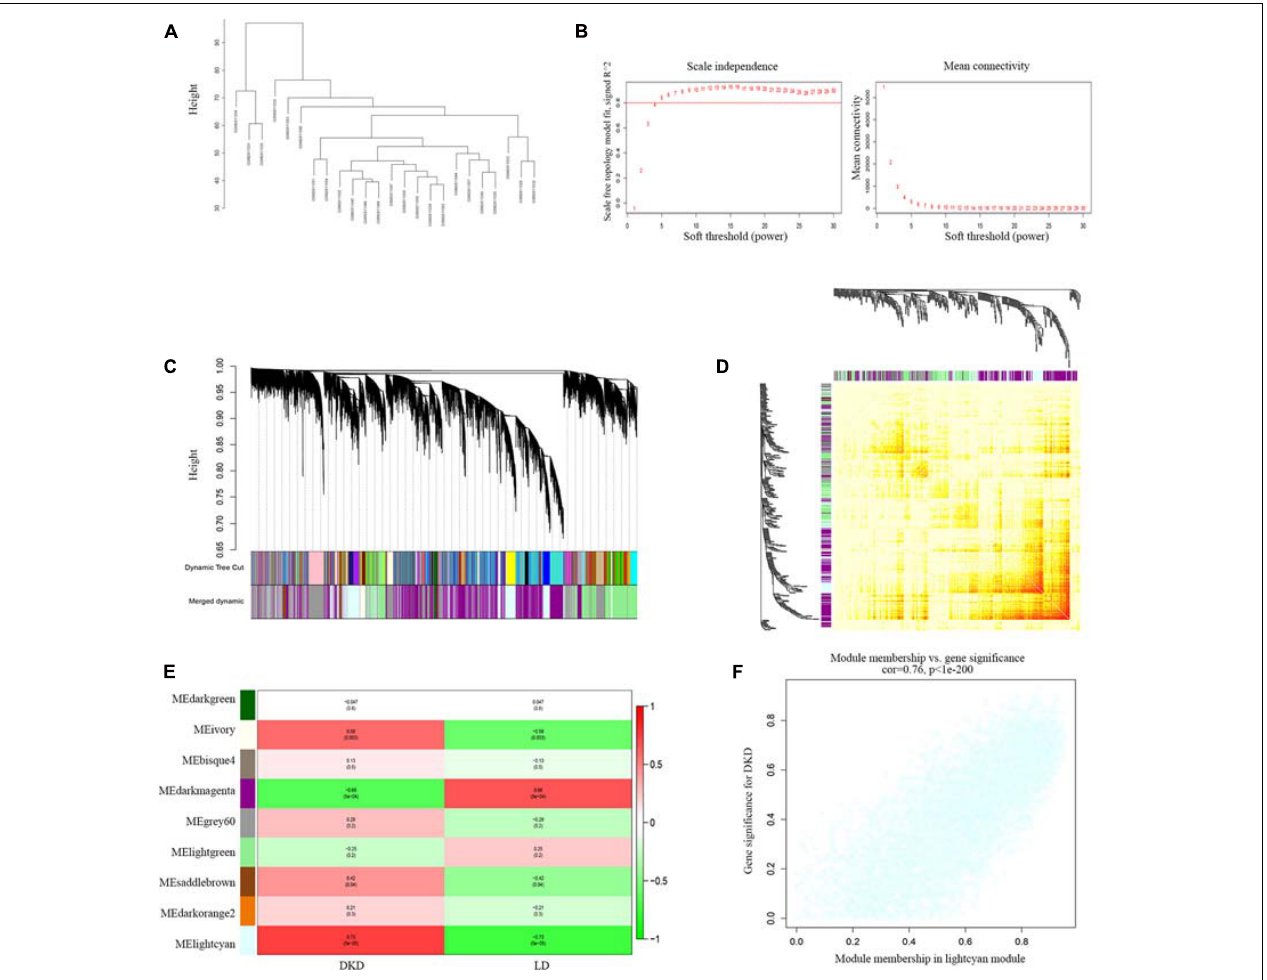
FIGURE 3 | WGCNA of seven patients with DKD and seventeen LDs gene expression profiles from GSE104954. (A) Sample clustering based on co-expressed data enrolled. (B) Analysis of soft-thresholding powers (fi) to fit the scale-free topology model and mean connectivity of the soft-thresholding powers. With a scale-free topological criterion > 0.8, 6 was chosen as the most fit power value. (C) Dendrogram of the gene modules. The branches represent different gene modules, and each leaf represents a gene in the cluster dendrogram. (D) Heatmap of the weighted gene co-expression correlations of all genes. (E) Correlation between module eigengenes and clinical traits. The clinical traits include DKD and LD. The corresponding correlations and P -values were presented. (F) Lightcyan module was identified to have the highest positive correlation with DKD-related clinical traits (correlation index = 0.76, P <